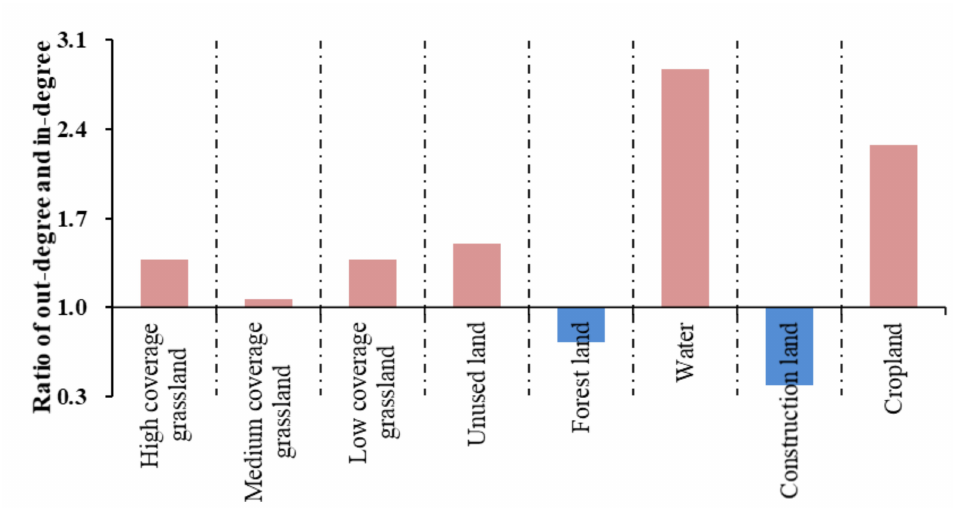
Figure 5. Changes of average out-degree, in-degree, and out-degree/in-degree between natural ecosystems and artificial ecosystems.